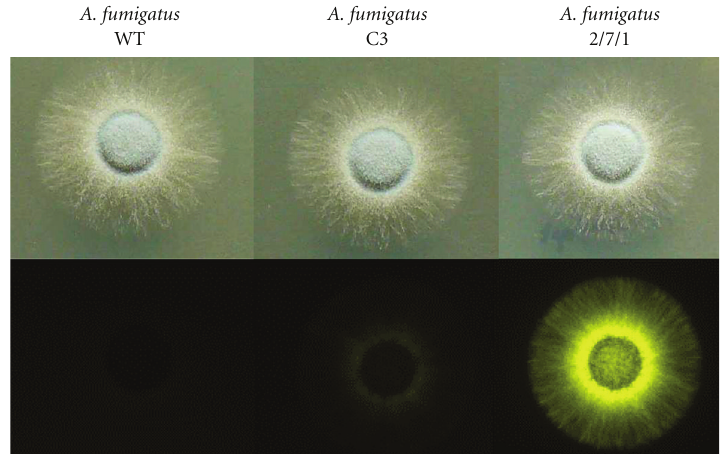
Figure 2: Visualisation of bioluminescence from A. fumigatus colonies. The A. fumigatus wild-type strain CBS144.89 and the bioluminescent strains C3 and 2/7/1 are shown. Strains were grown for 48 h in the presence of 1 mM D-luciferin on glucose minimal medium. The upper lane shows a daylight photograph, the bottom line bioluminescence images of the colonies acquired by a medium sensitive Versa Doc luminescence imaging system. Strain C3 carries four ectopic integrations of the P. pyralis luciferase gene codon adapted for expression in mammalian cells. Only a moderate light emission is detected. Strain 2/7/1 carries two integrations of the P. pyralis gene codon optimised for expression in A. fumigatus . Light emission is strongly